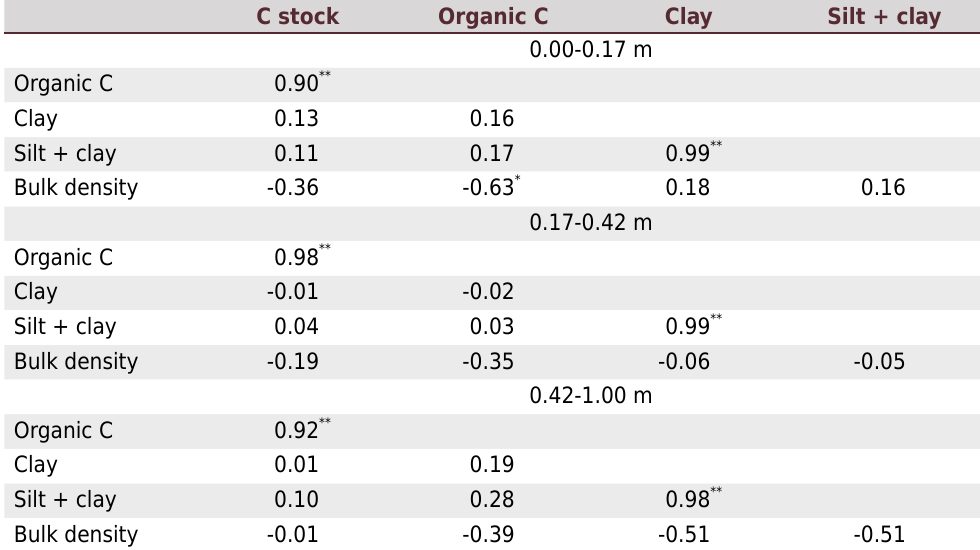
Table 4. Correlation matrix of soil C (stock and content) and some soil properties (n =